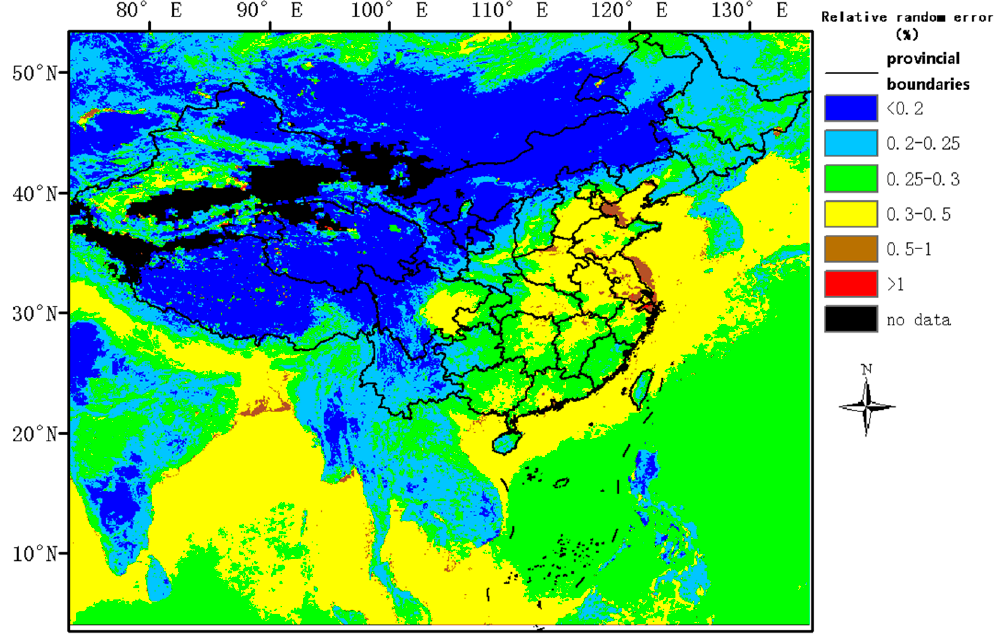
Figure 11. Performance evaluation results. The relative random errors were calculated in terms of the schematic diagram shown in Figure 1. Parameters for the hardware model are from Table 3,